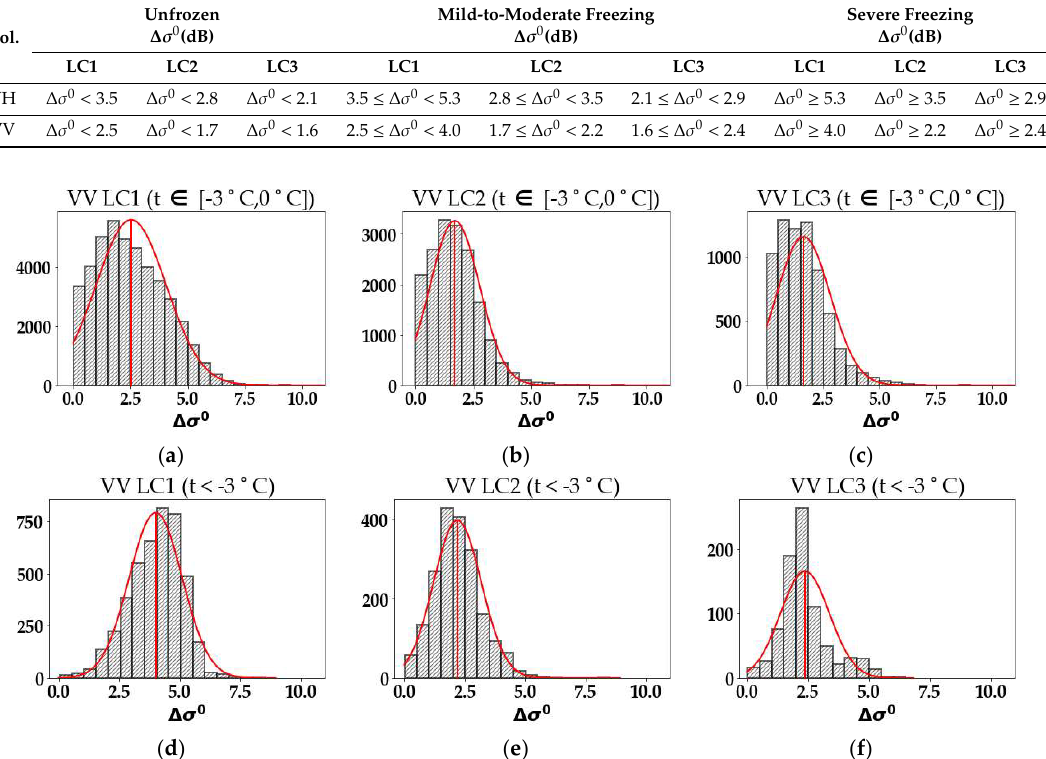
Figure 6. Distributions of ∆ σ 0 in VV polarization for the three main land cover classes: ( a , d ) cereals LC1, ( b , e ) meadows LC2, and ( c , f ) orchards and vineyards LC3. ( a , b , and c ) ∆ σ 0 over LC1, LC2, and LC3, respectively, for temperatures − 3 ◦ C ≤ t ≤ 0 ◦ C, ( d , e , and f ) ∆ σ 0 over LC1, LC2, and LC3, respectively, for t ≤ − 3 ◦ C. The Y-axis represents the frequency of different ∆ σ 0 ranges over the entire plots. The red curve represents the fitted normal functions, while the red vertical line represents the